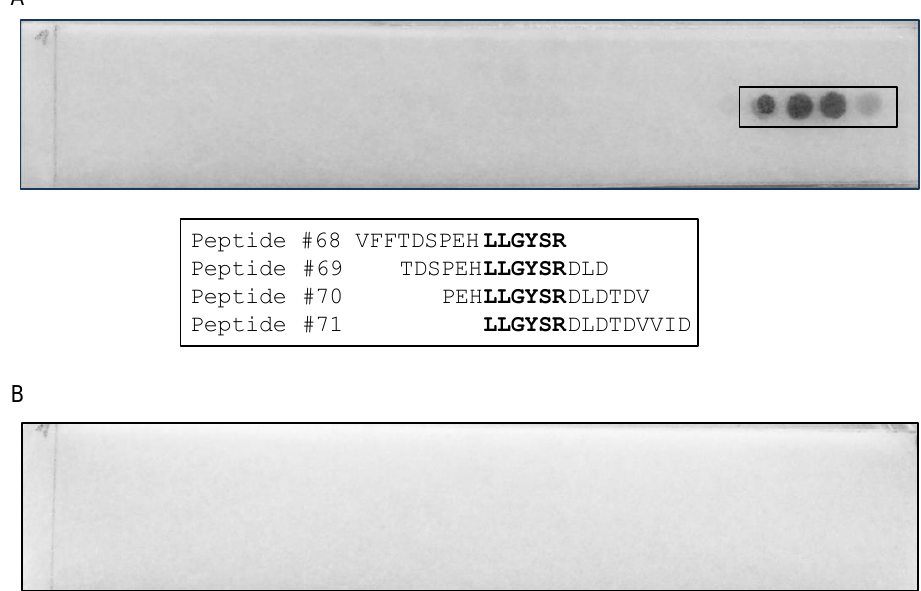
Figure 5. A cellulose membrane, containing 372 15-mere peptides covering the whole F13 protein was used for epitope mapping. MAb 15B6 ( A ) recognised four peptide spots (No. 68-71). The epitope was mapped to 202-VFFTDSPEHLLGYSRDLDTDVVID-225. The minimal sequence essential for binding is 211-LLGYSR-216. The secondary Ab, used as a negative control ( B ), did not bind to any spots.